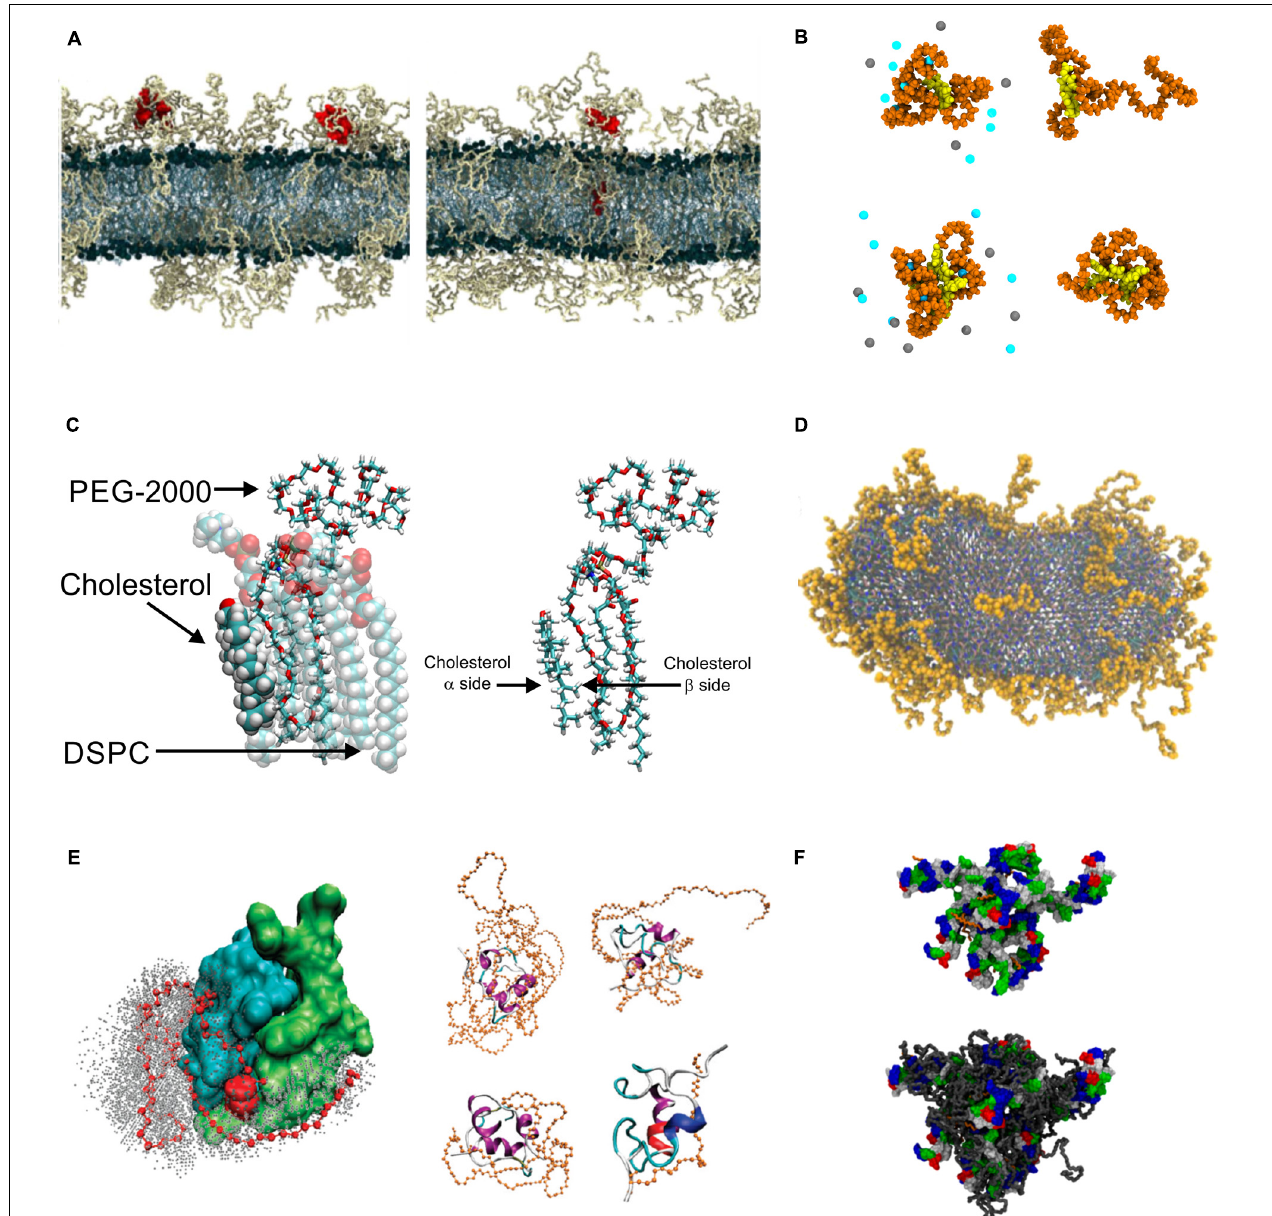
FIGURE 6 | PEGylation. (A) Snapshot showing PEGylated lipid bilayer, reproduced with permission from Dzieciuch et al. (2015), Copyright (2015) American Chemical Society; (B) PEGylated biochanin (upper) and tetra-phenyl-porphyrin (lower), with salt (left) and without salt (right), reproduced with permission from Rissanen et al. (2014), Copyright (2014) American Chemical Society; (C) Snapshots showing DSPC, cholesterol and DSPE-PEG molecules, reproduced with permission from Magarkar et al. (2014), Copyright (2014) American Chemical Society; (D) PEGylated bicelle containing 10.5 mol % DSPE-PEG, reproduced from Viitala et al. (2019), Copyright: 2019; (E) PEGylated insulin, left panel shows position of PEG atoms during simulations, right panel shows snapshots of insulin PEGylated with PEG of various length, reproduced with permission from Yang et al. (2011), Copyright (2011) American Chemical Society.